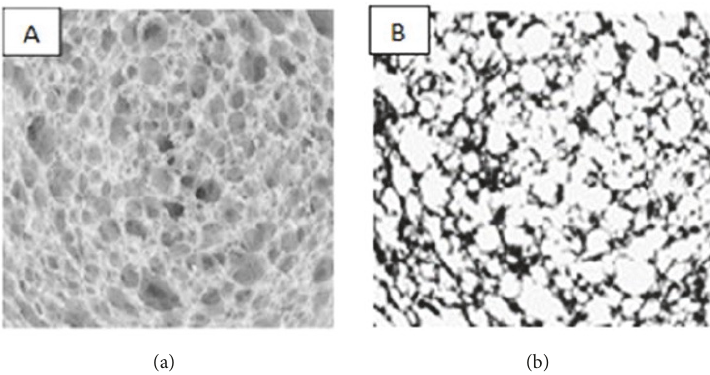
Figure 4: Original 2D Gray Image (a) and segmented (b) gas cells using K-means algorithm